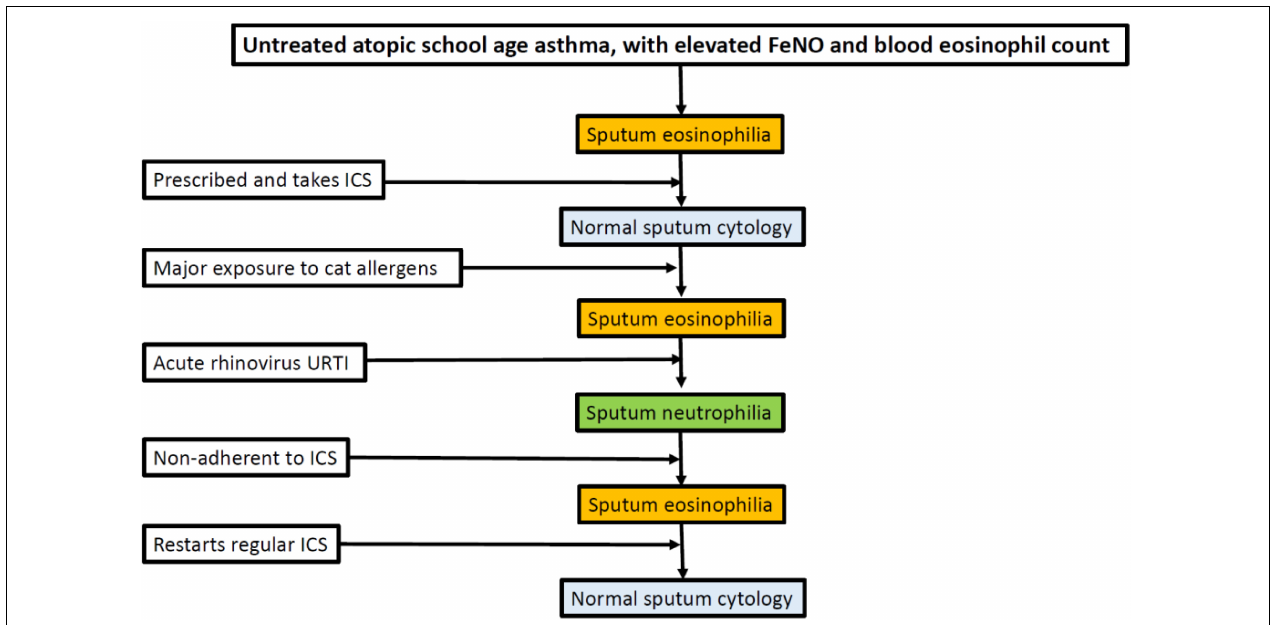
FIGURE 1 | Potential variability of sputum phenotype in an individual who is cat allergic and has asthma. ICSs, inhaled corticosteroids; FeNO, fractional exhaled nitric oxide; URTI, upper respiratory tract infection.